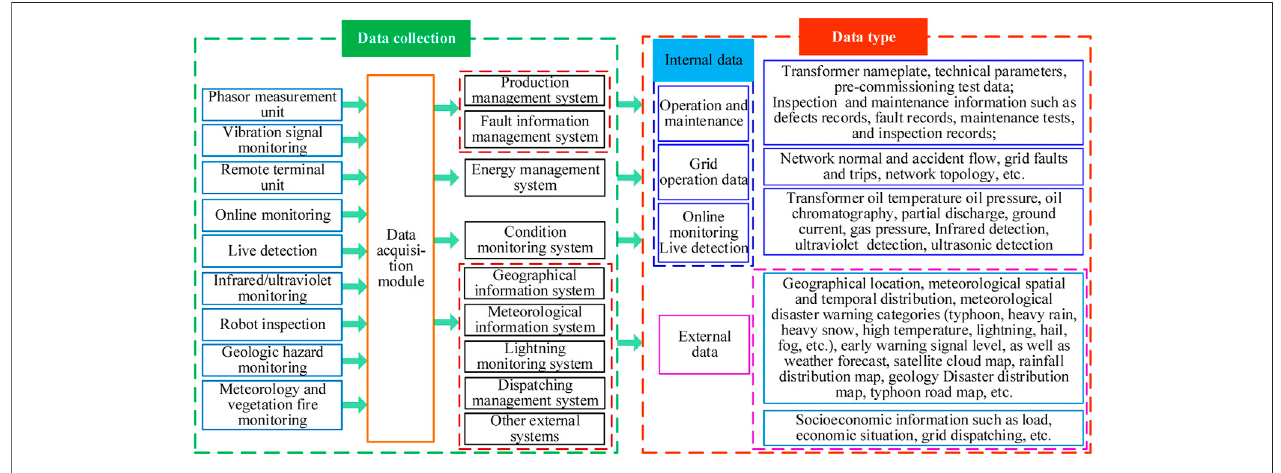
FIGURE 6 | Transformer data collection and classi fi